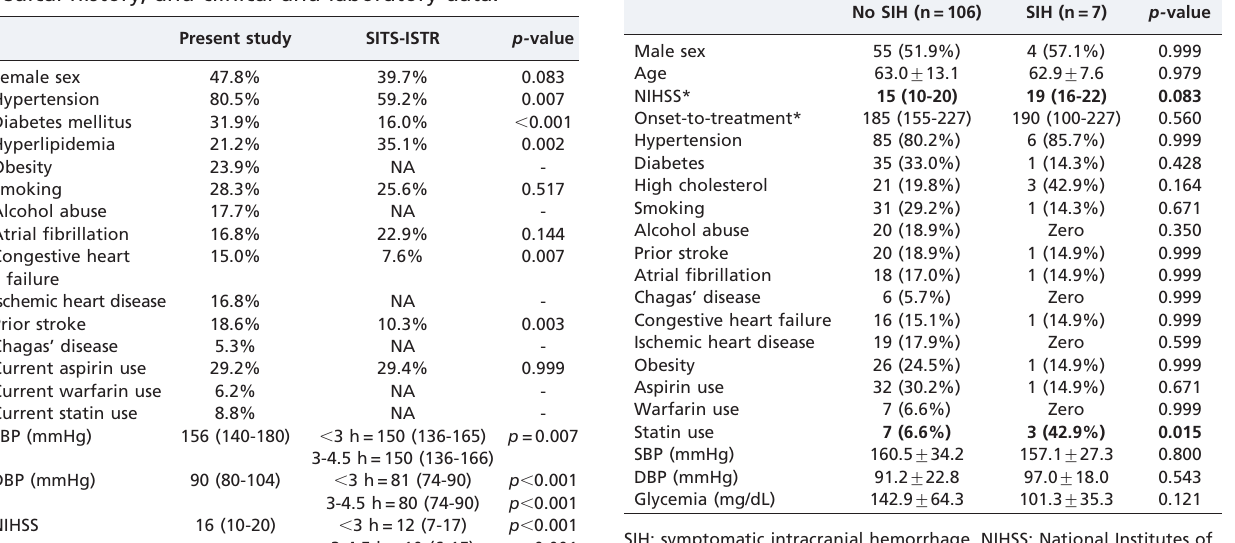
SIH: symptomatic intracranial hemorrhage. NIHSS: National Institutes of Health Stroke Scale. SBP: systolic blood pressure at the time of admission. DBP: diastolic blood pressure at the time of admission. Categorical variables are expressed as events (percentage). Numerical variables are expressed as the mean ¡ standard deviation. *Expressed as median (interquartile